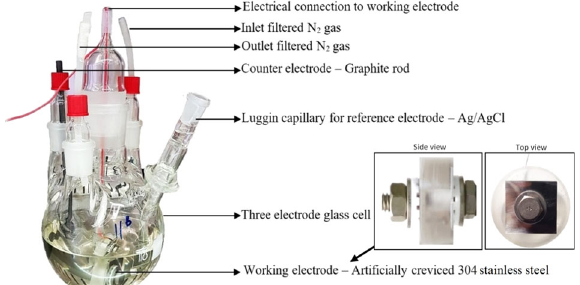
Fig. 12 Electrochemical test setup used to evaluate the crevice corrosion of 304 stainless steel. Inset shows top and side view of working electrode, i.e. stainless steel coupon, mounted in epoxy resin and assembled with crevice